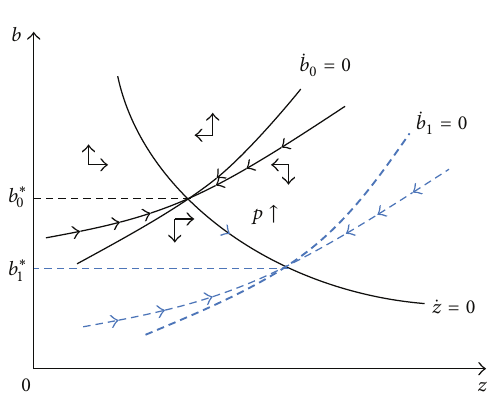
Figure 4: The phase diagram and the effect of a permanent terms- of-trade deterioration for Case